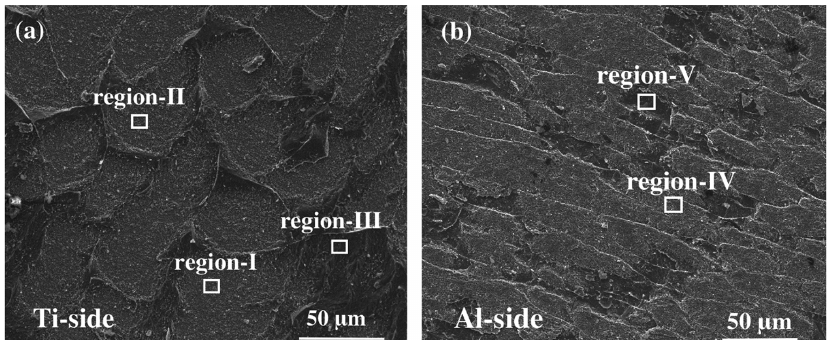
Figure 8: Fracture morphology of the Ti/Al diffusion bonded joint obtained at 625°C.